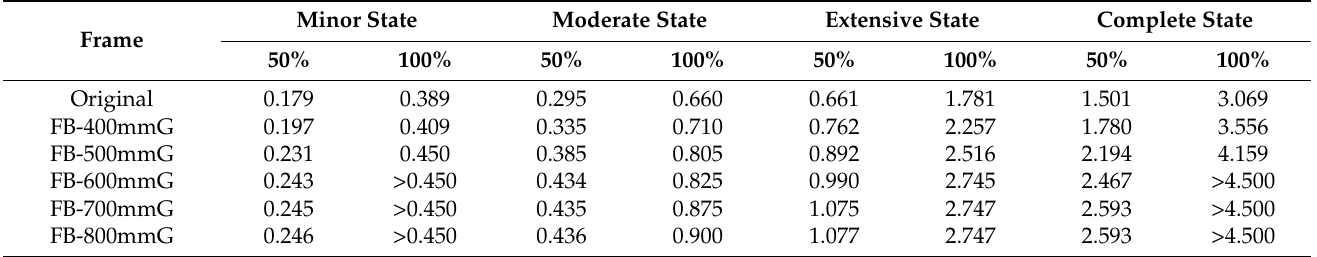
Figure 14. Fragility curves of the original and CFRP flange ‐ bonding frames in each state. Table 8. The PGA (g)’s accordance with the probability of 50% and 100% of each state for FB ‐ GFRP frames.